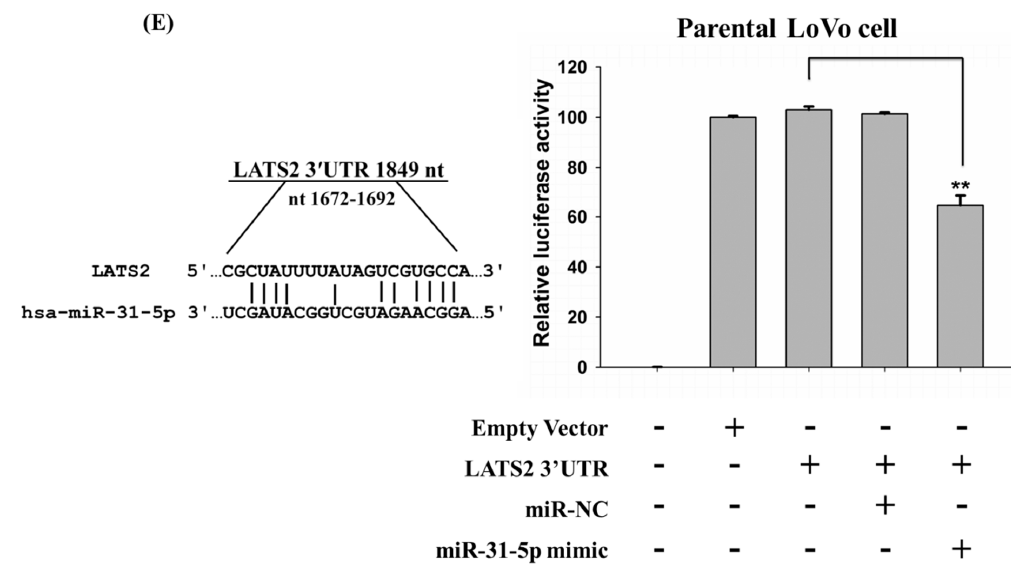
Figure 4. MiR-31-5p regulates LATS2 mRNA and protein expression by targeting the 3’UTR in LoVo cells and OR-LoVo cells. ( A ) We combined the miRTarBase, miRDB, and TargetScanHuman databases to predict the putative targets of miR-31-5p, and there were 18 predicted targets that overlapped among the three online databases. ( B ) Real-time RT-PCR analysis was used to confirm the mRNA expression levels of LATS2 in the two cell lines. *** p < 0.001 vs. OR-LoVo cells. ( C ) Protein expression of LATS2 in LoVo cells and OR-LoVo cells by Western blotting. Quantification of LATS2 protein expression ( n = 3, the 3 lanes for each cell line loaded in the Western blot which were harvested from the total protein of the three different passages). *** p < 0.001 vs. OR-LoVo cells. ( D ) Protein expression of LATS2, p21, and p27 in LoVo or OR-LoVo cells transfected with the miR-31-5p mimic (40 nM), inhibitor (40 nM), or scrambled miRNA (40 nM) (mimic NC or inhibitor NC), or treatment with or without OXA (45 µ M) by Western blotting. The experiments were performed in triplicate. ( E ) Luciferase activity assays of the activity of luciferase vectors containing the LATS2 3'-UTR were performed following transfection with miR-31-5p or negative control (NC) for 24 h using the Dual-Luciferase Reporter Assay System (Promega, Madison, WI, USA). ** p < 0.01 vs. LoVo cells LATS2 3’UTR group .